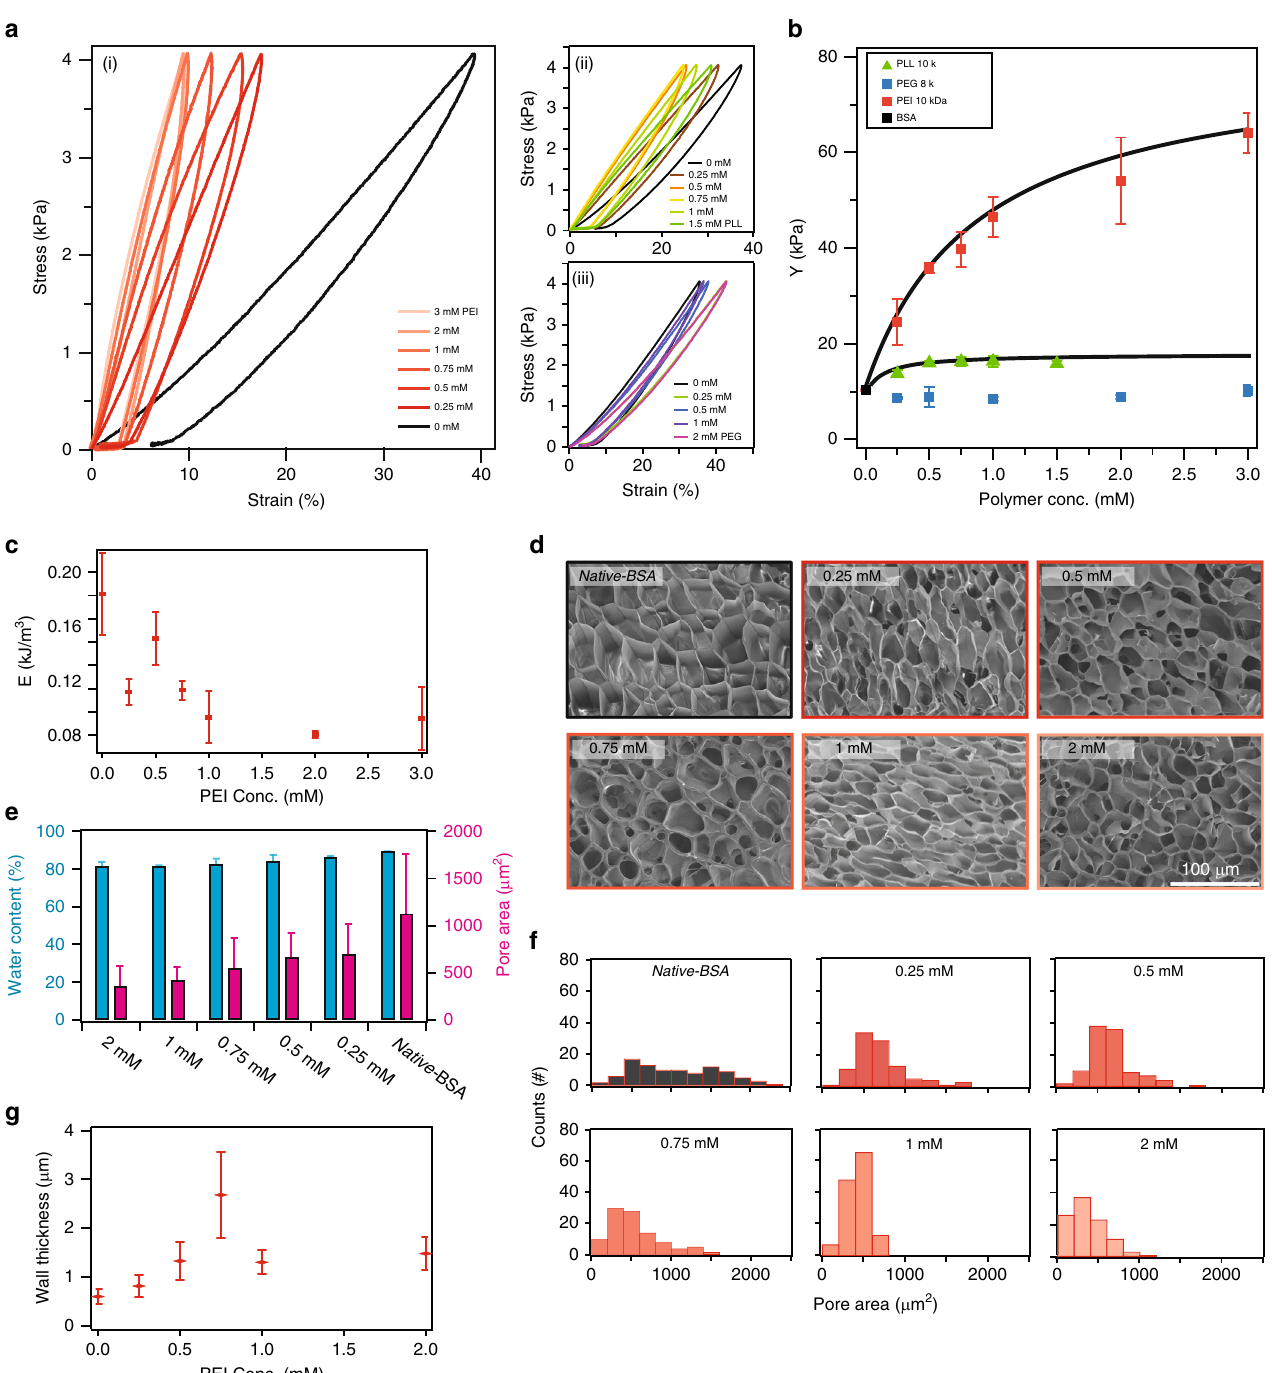
Fig. 2 Characterizations of BSA hydrogels as a function of polyelectrolyte intake. a (i) Stress – strain curves of native- BSA, and incubated with various concentrations of PEI ranging from 0 to 3 mM; (ii) stress – strain curves of native- BSA and incubated with various concentrations of PLL ranging from 0 to 1.5 mM; (iii) stress – strain curves of different BSA-based hydrogels treated with various PEG concentrations ranging from 0 to 3 mM. Each curve represents the average of three different measurements. b Average Young ’ s moduli calculated from stress – strain curves of native- BSA, and incubated with PEG (blue), PLL (green), and PEI (red) as a function of the polymer concentrations. Fits represent a Langmuir-like behavior, with equilibrium constants of K PLL = 1.1 and K = 5.3 mM − 1 . c Relationship between PEI concentration and energy dissipation of treated BSA hydrogels. The energy dissipation was calculated from PEI the hysteresis area enclosed in the stress – strain curves. d SEM images of BSA-based hydrogels incubated with PEI at various concentrations. e Average pore-area size and water content measurements of native and PEI-treated hydrogel samples. f Pore-area size distribution histograms as derived from SEM images. g The relationship between wall thickness of the pores and PEI concentration. Error bars in all panels are SD from n = 3 independent hydrogel